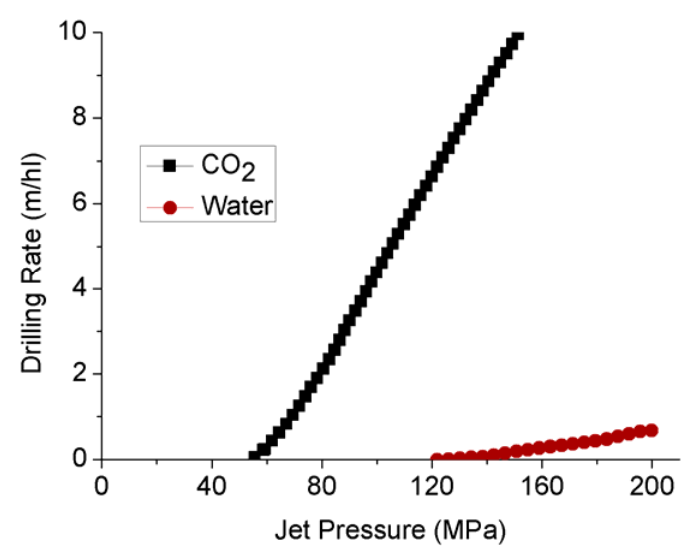
Figure 14. Comparison of drilling rates between super-critical CO 2 and water [91].